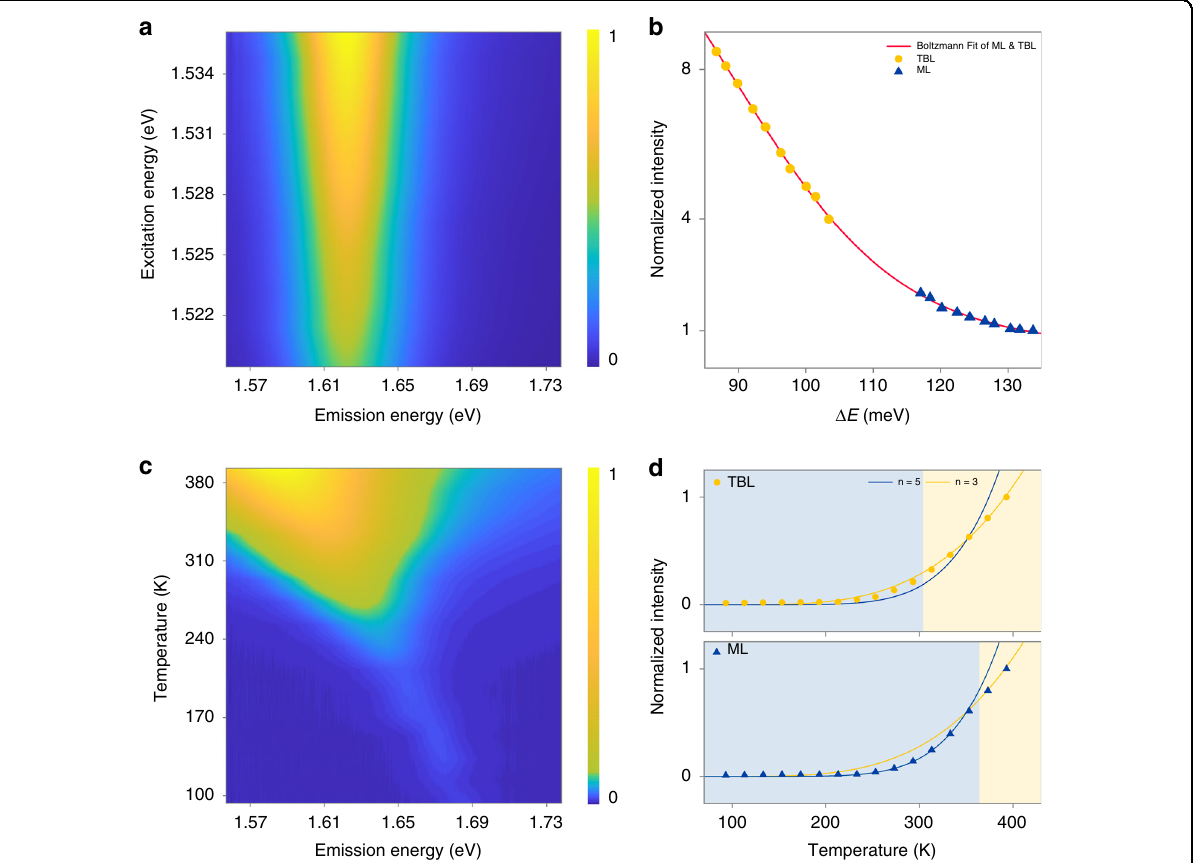
Fig. 2 Energy gain and temperature dependence of UPC in a 5.5° twisted bilayer WSe 2 . a Excitation-energy-dependent UPC spectra in the WSe 2 TBL. b Energy-gain-dependent UPC intensity plots of TBL (yellow dots) and ML (blue triangles), the intensity at the highest energy gain of ML is normalized as 1, the red solid line fi ts both ML and TBL results as a whole based on the Boltzmann model (Table S1). c Temperature-dependent UPC spectra in the WSe 2 TBL. d Temperature-dependent UPC intensity plots of TBL (top panel) and ML (bottom panel); the blue (yellow) solid line represents the fi tting based on Bose-Einstein distribution when the number of participating phonons n = 5 ( n =